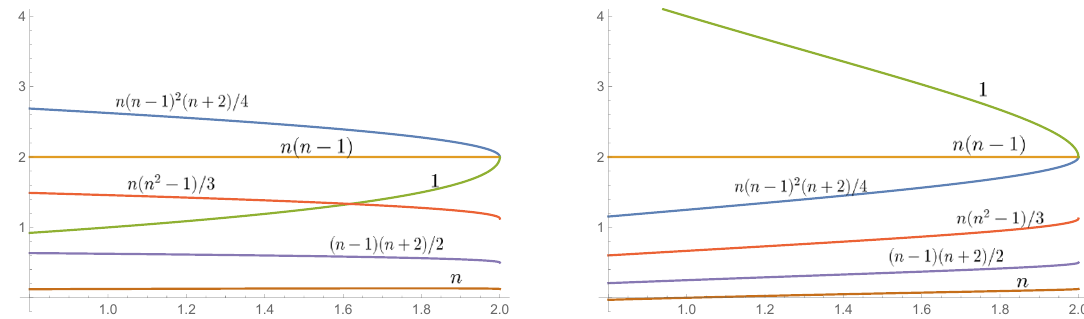
Figure 2. Dimensions and multiplicities of light scalar operators as functions of n in the critical (left) and low-T (cid:12)xed points